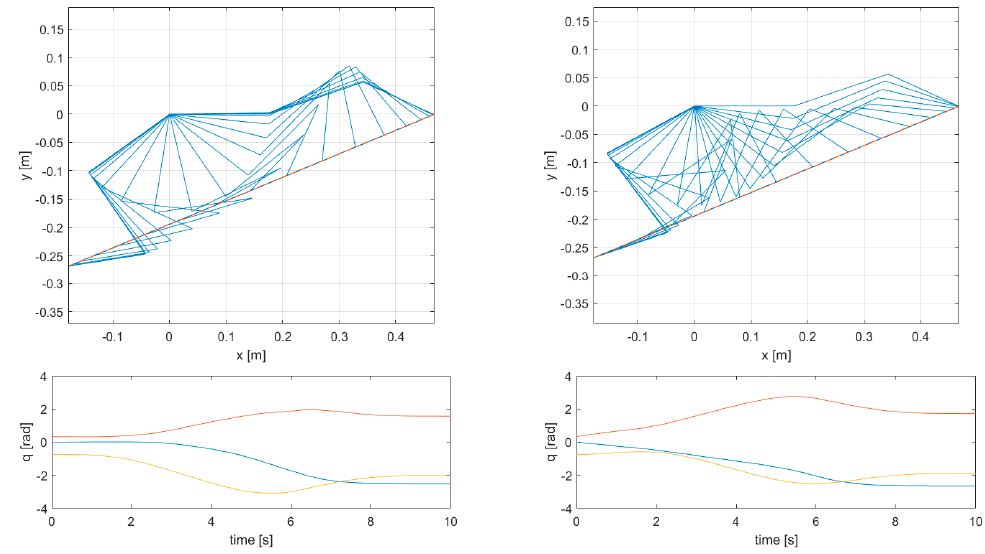
Figure 12. Trajectory 4, comparison between PMKE ( left ) and global optimal solution ( right ). First joint: blue lines; second joint: red lines; third joint: yellow lines.